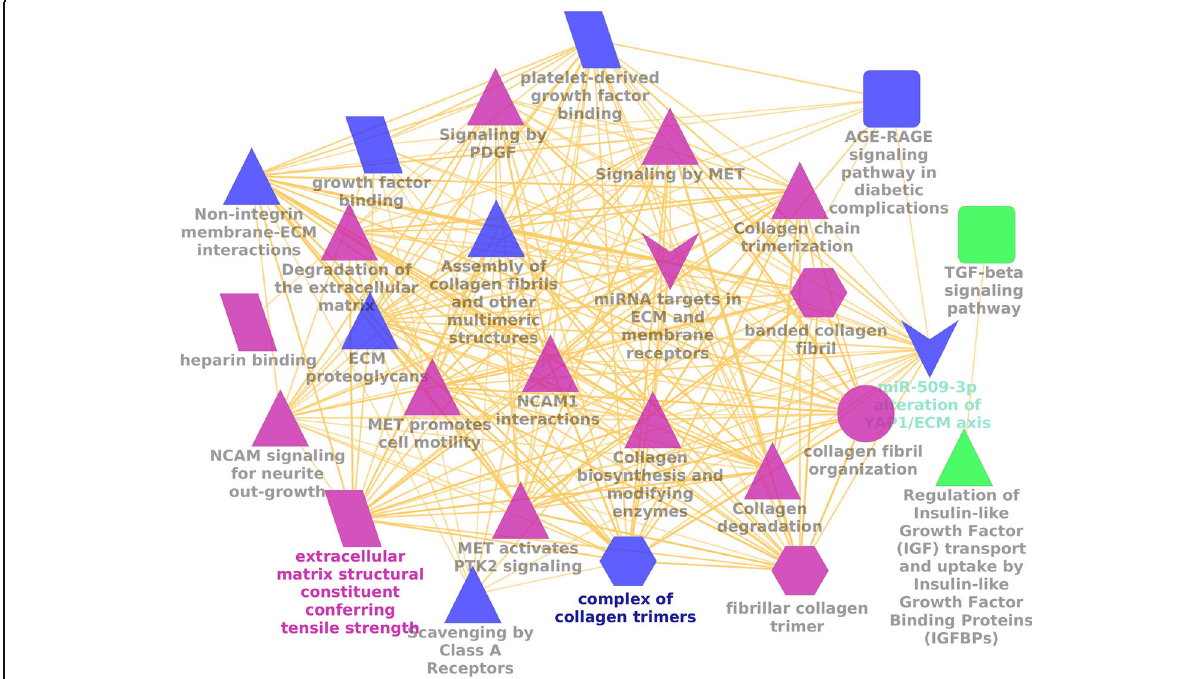
Fig. 4 Inter-relational pathway analysis and GO enrichment of the target gene clusters. The pathways are shown in arrow and triangle representation and the GO in ellipses (biological process), hexagon (molecular function), and parallelogram (cellular